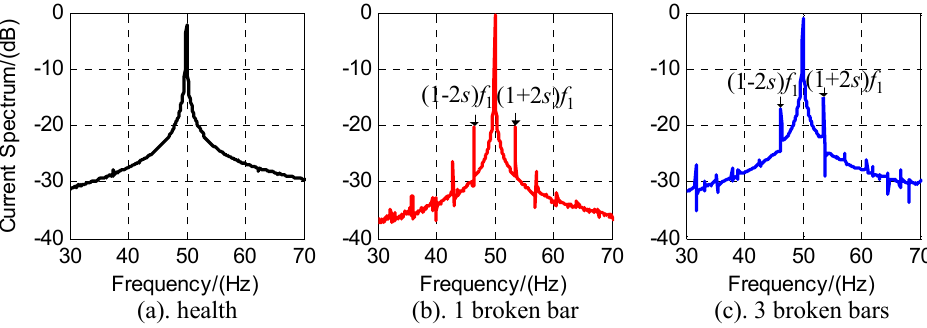
Figure 23. Motor currents under rotor faults (top: health, middle: 1 broken bar, bottom: 3 broken bars).